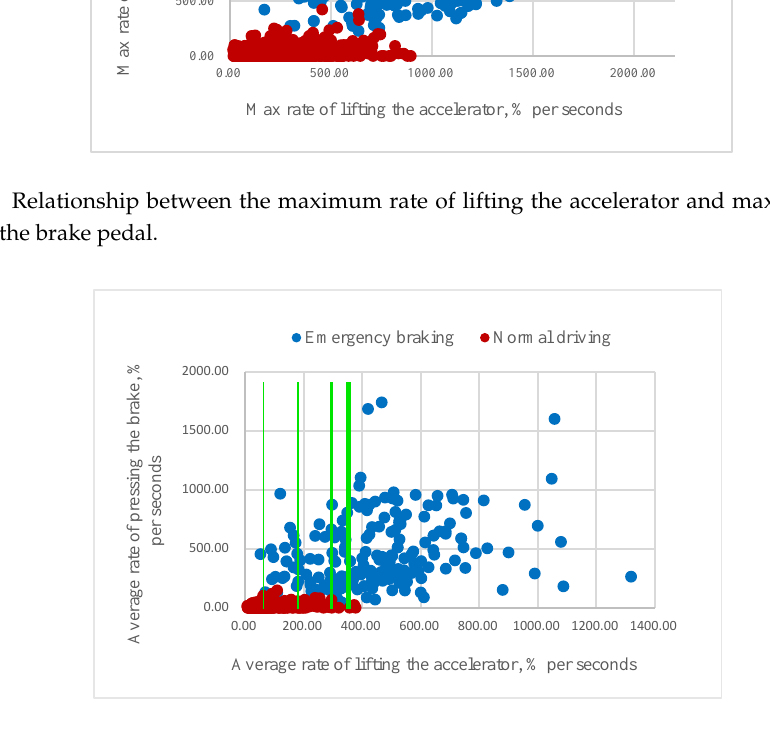
Figure 9. Relationship between the maximum rate of lifting the accelerator and maximum rate of pressing the brake pedal.